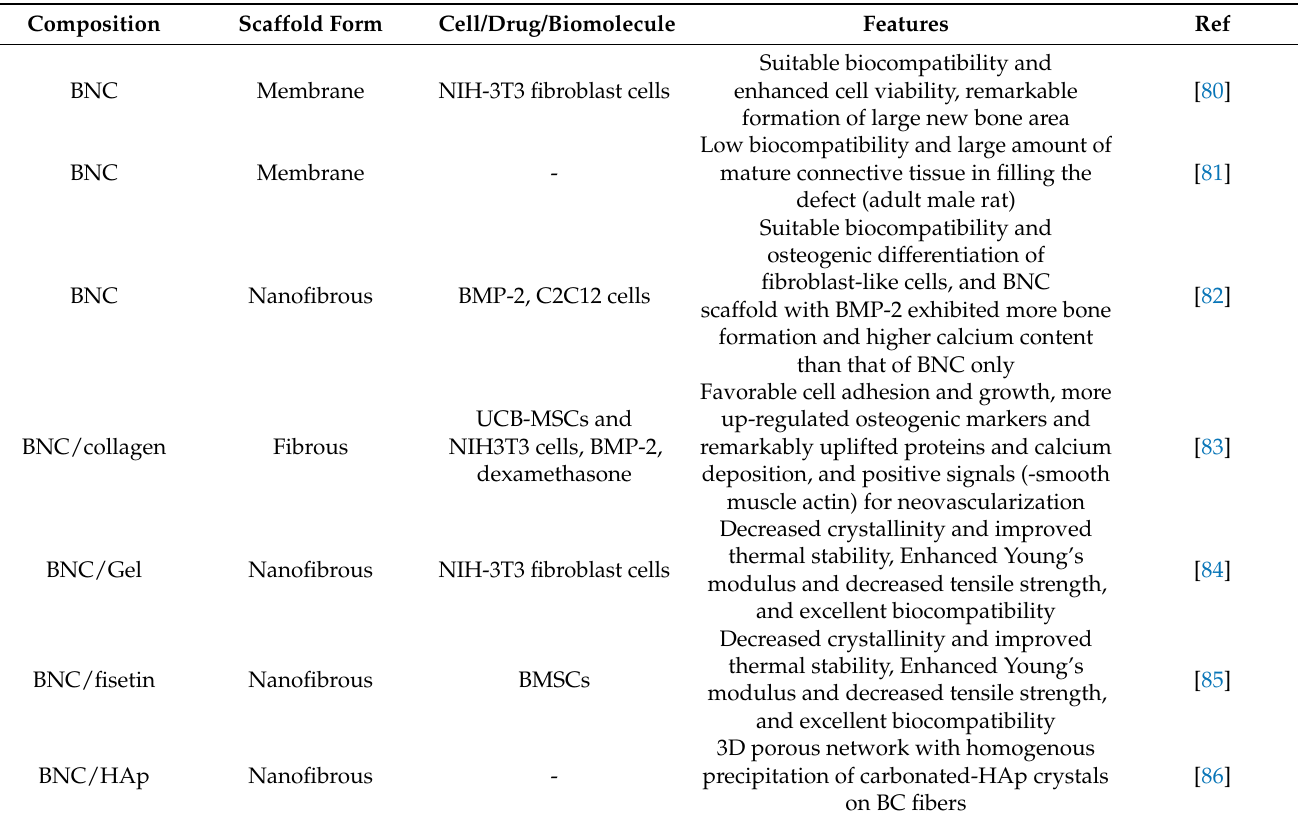
Table 4. Examples of the potential of nanocellulose biomaterials in the regeneration of bone tissues